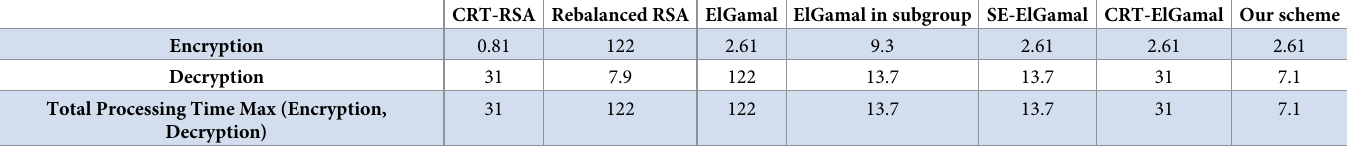
Table 2. Practical execution time